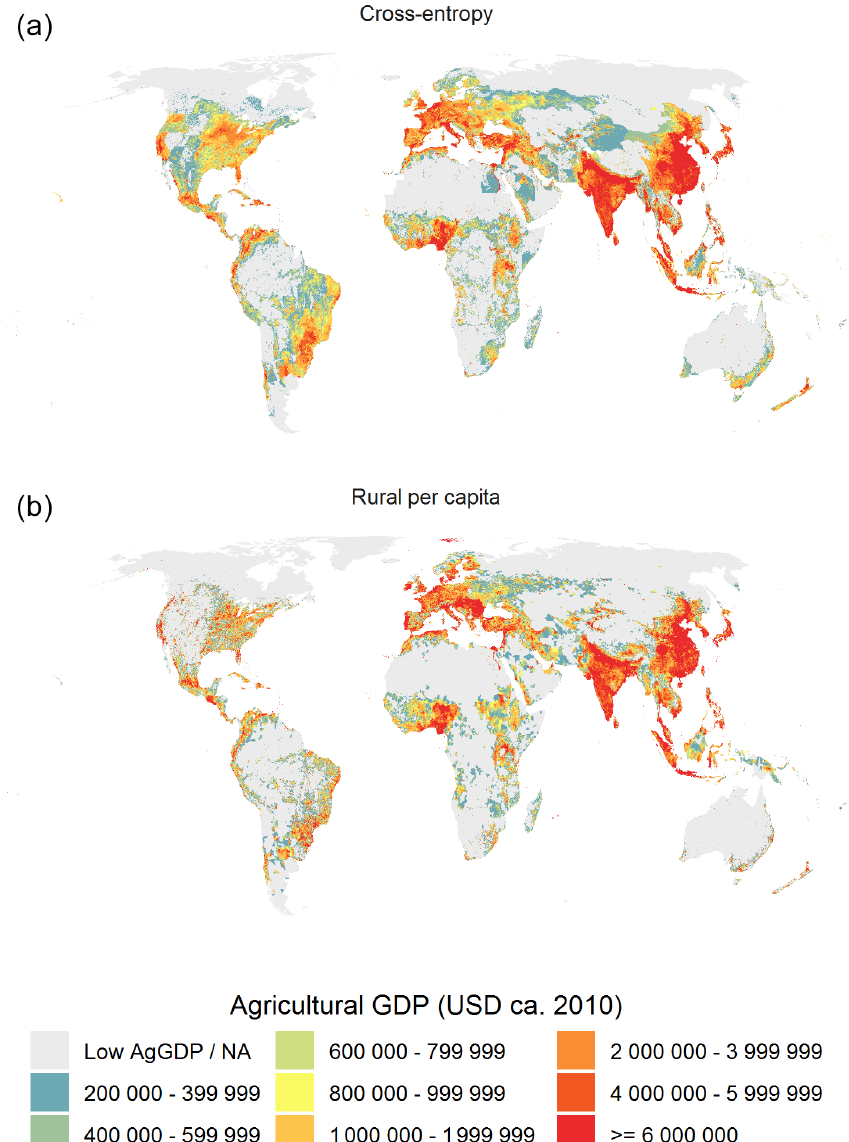
Figure 7. A panel map of gridded AgGDP circa 2010 from the cross-entropy model (a) and from the rural per capita population model (b) Au- thors’